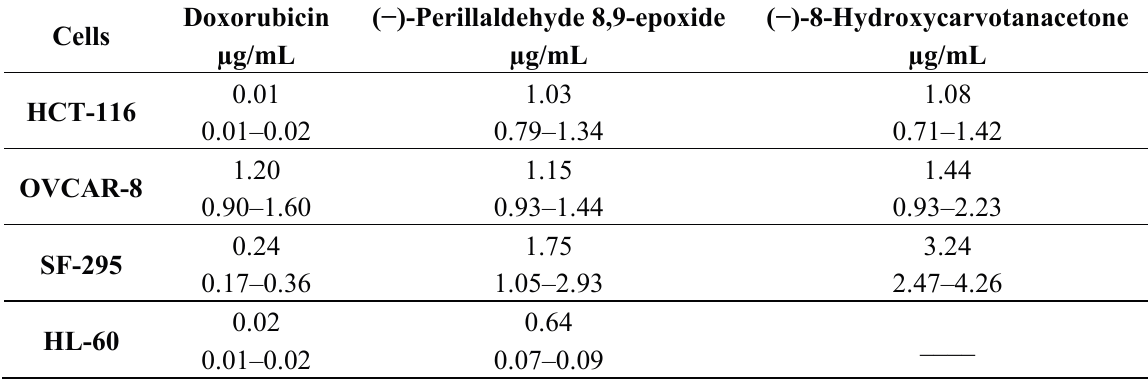
Table 2. Cytotoxic activity of ( − )-perillaldehyde 8,9-epoxide and ( − )-8- hydroxycarvotanacetone on tumor cell lines. Experiments were performed in triplicate. Doxorubicin Cells